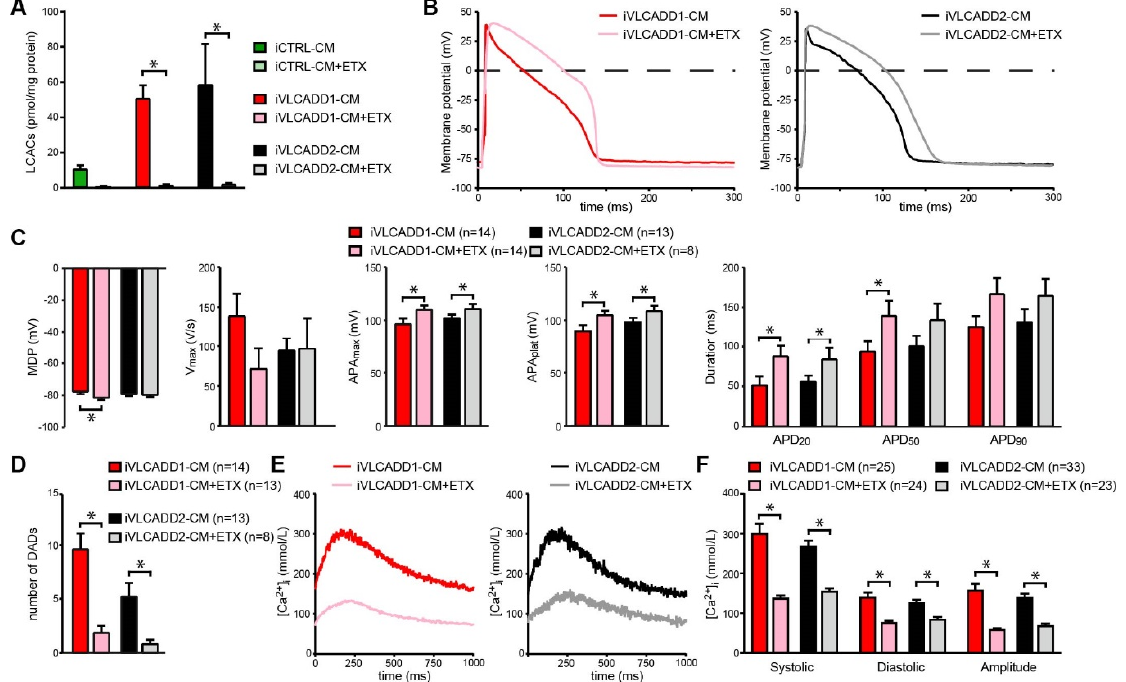
Figure 3. Rescue of electrophysiological abnormalities in iVLCADD1-CMs and iVLCADD2-CMs after pre-incubation with Etomoxir (ETX; 100 µ mol / L). ( A ) Intracellular acylcarnitine levels in iVLCADD1- CMs, iVLCADD2-CMs and iCTRL-CMs after ETX incubation for 96 h. Sum of LCAC (C12-, C14-,